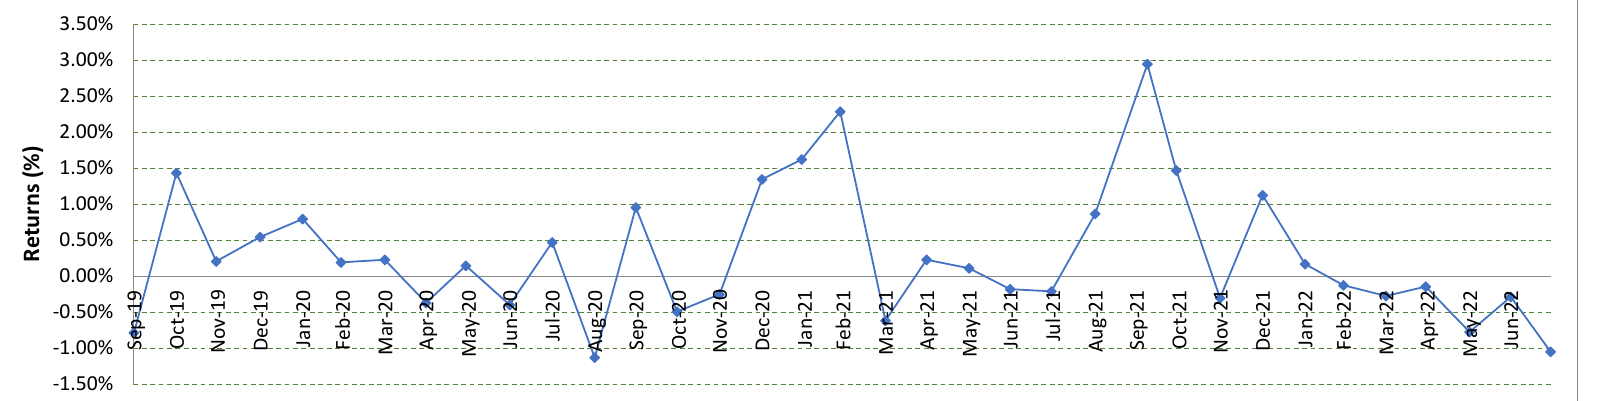
Figure 4. Minimum-variance portfolio: long-only.